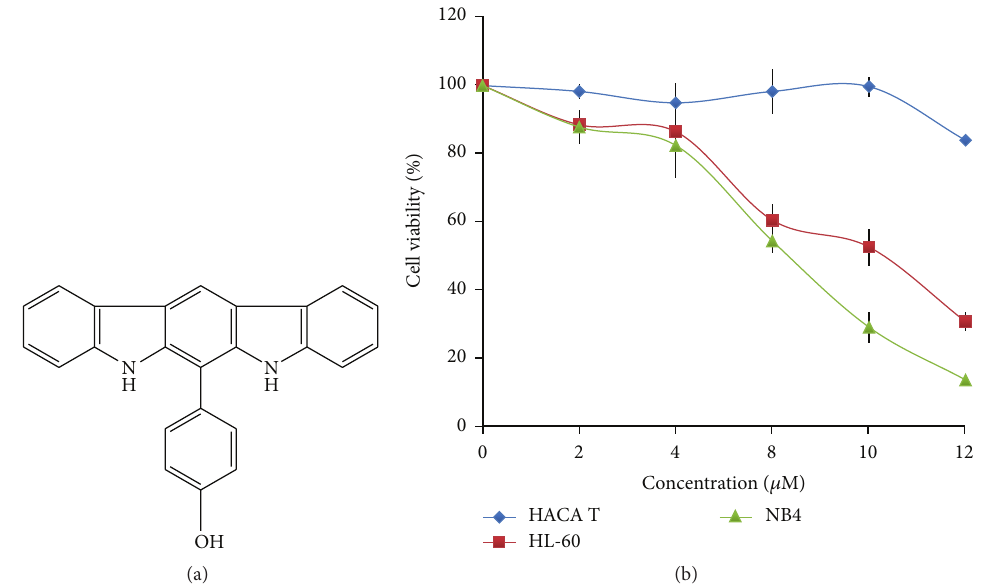
Figure 1: Structure of ZW2-1 and its effects on cell proliferation. (a) Chemical structure of ZW2-1. (b) Effects of ZW2-1 on cell proliferation of human leukemia cell line HL-60, NB4, and immortal human keratinocyte cell line Haca T. The values are represented as mean ± SD of three independent experiments with five replicates in